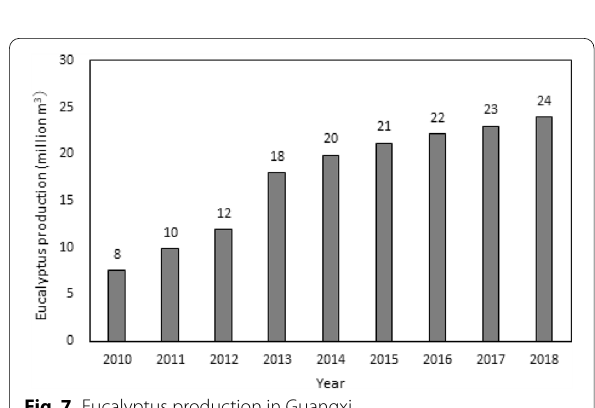
Fig. 7 Eucalyptus production in Guangxi